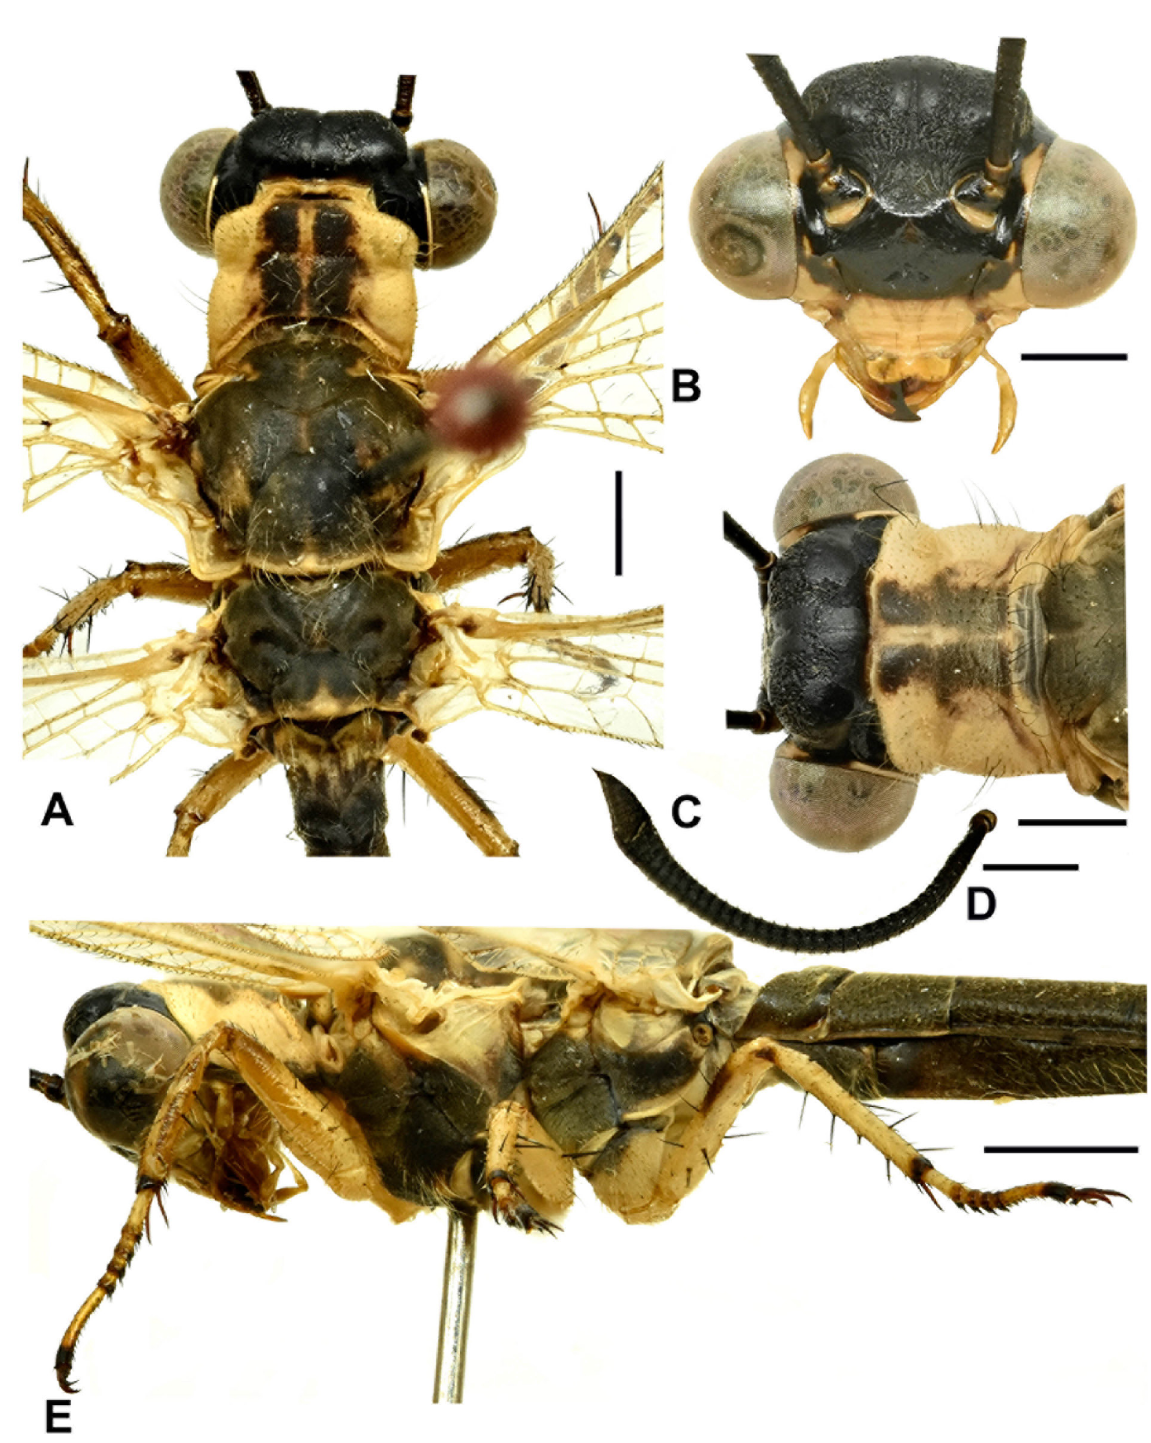
Fig. 18. Myrmeleon trivialis Gerstaecker, 1885 (CAUPK000025). A . Dorsal habitus of head and thorax. B . Head, frontal view. C . Head and pronotum, dorsal view. D . Antenna. E . Habitus, lateral view. Scale bars: A = 2.0 mm; B–D = 1.0 mm; E = 3.0